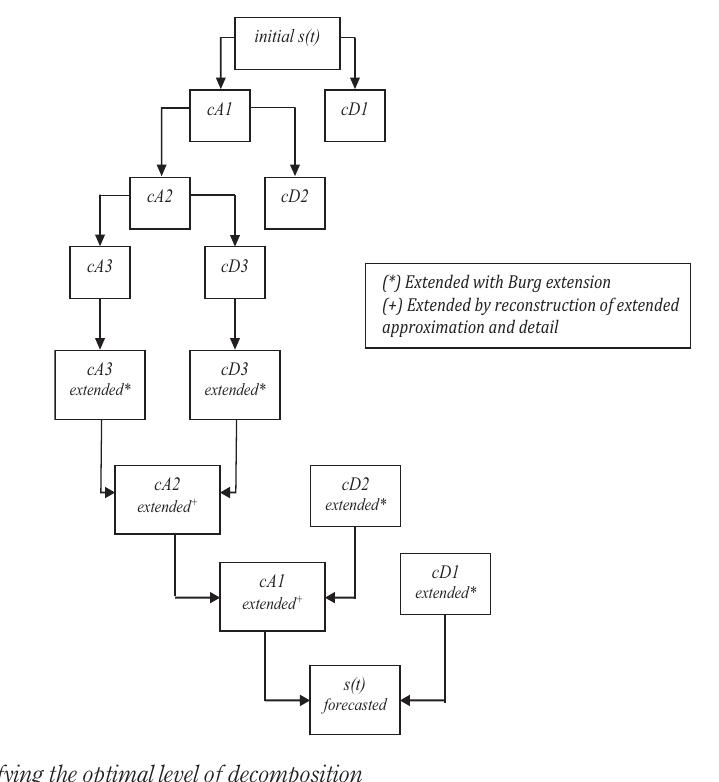
Identifying the optimal level of decomposition